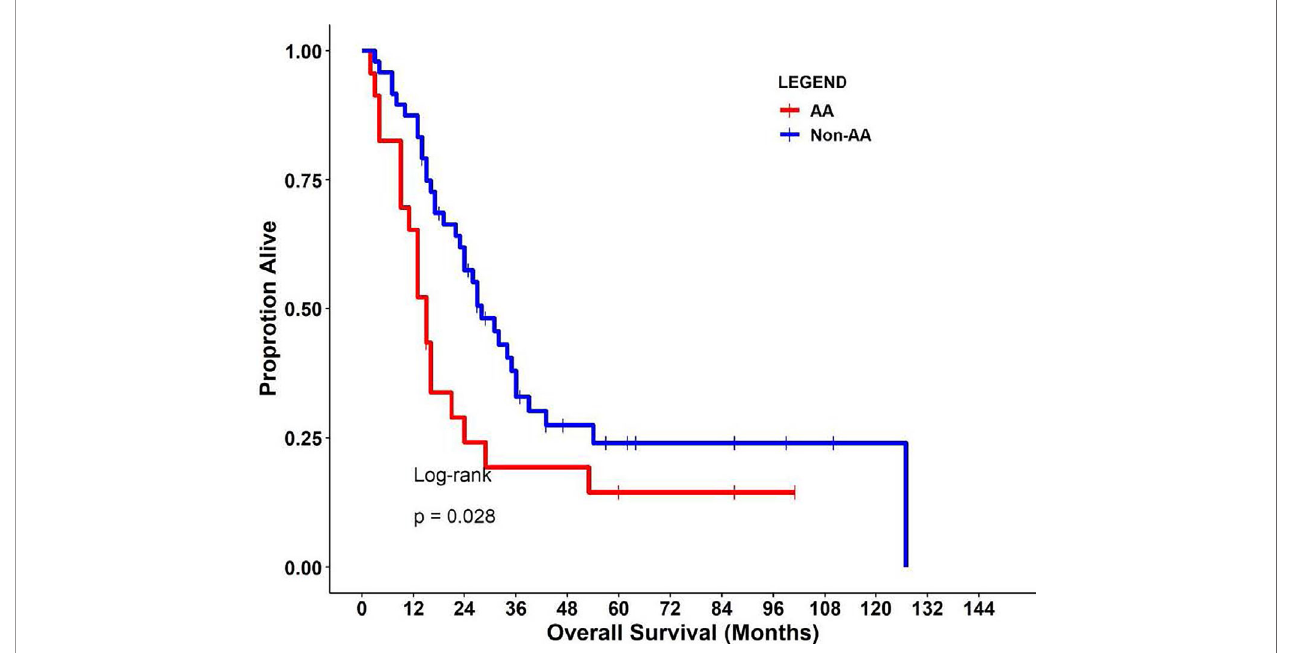
FIGURE 1 | Kaplan-Meier curves (log-rank test) of overall survival in the study